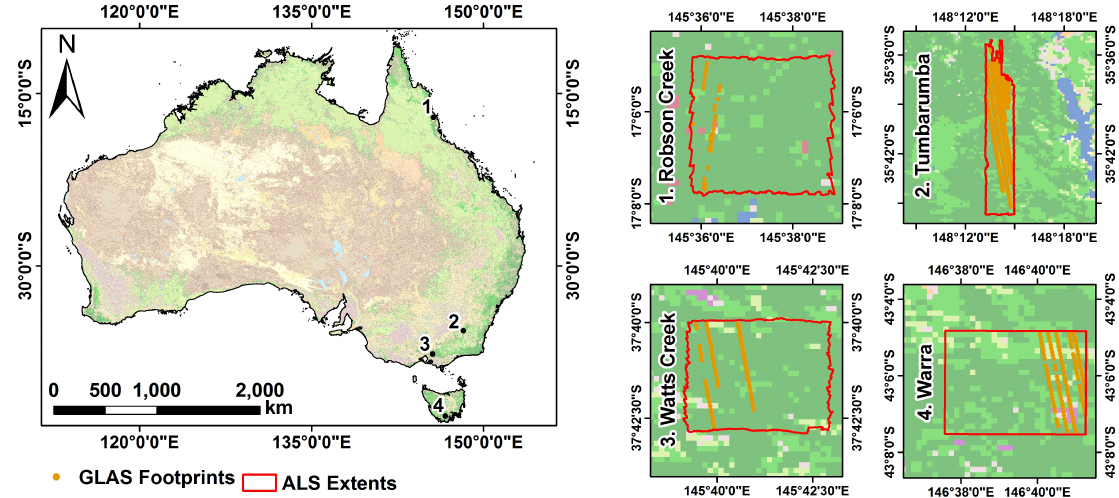
Figure 1. Location of study sites. ALS extents are shown in red, and GLAS footprint centres are indicated by an orange